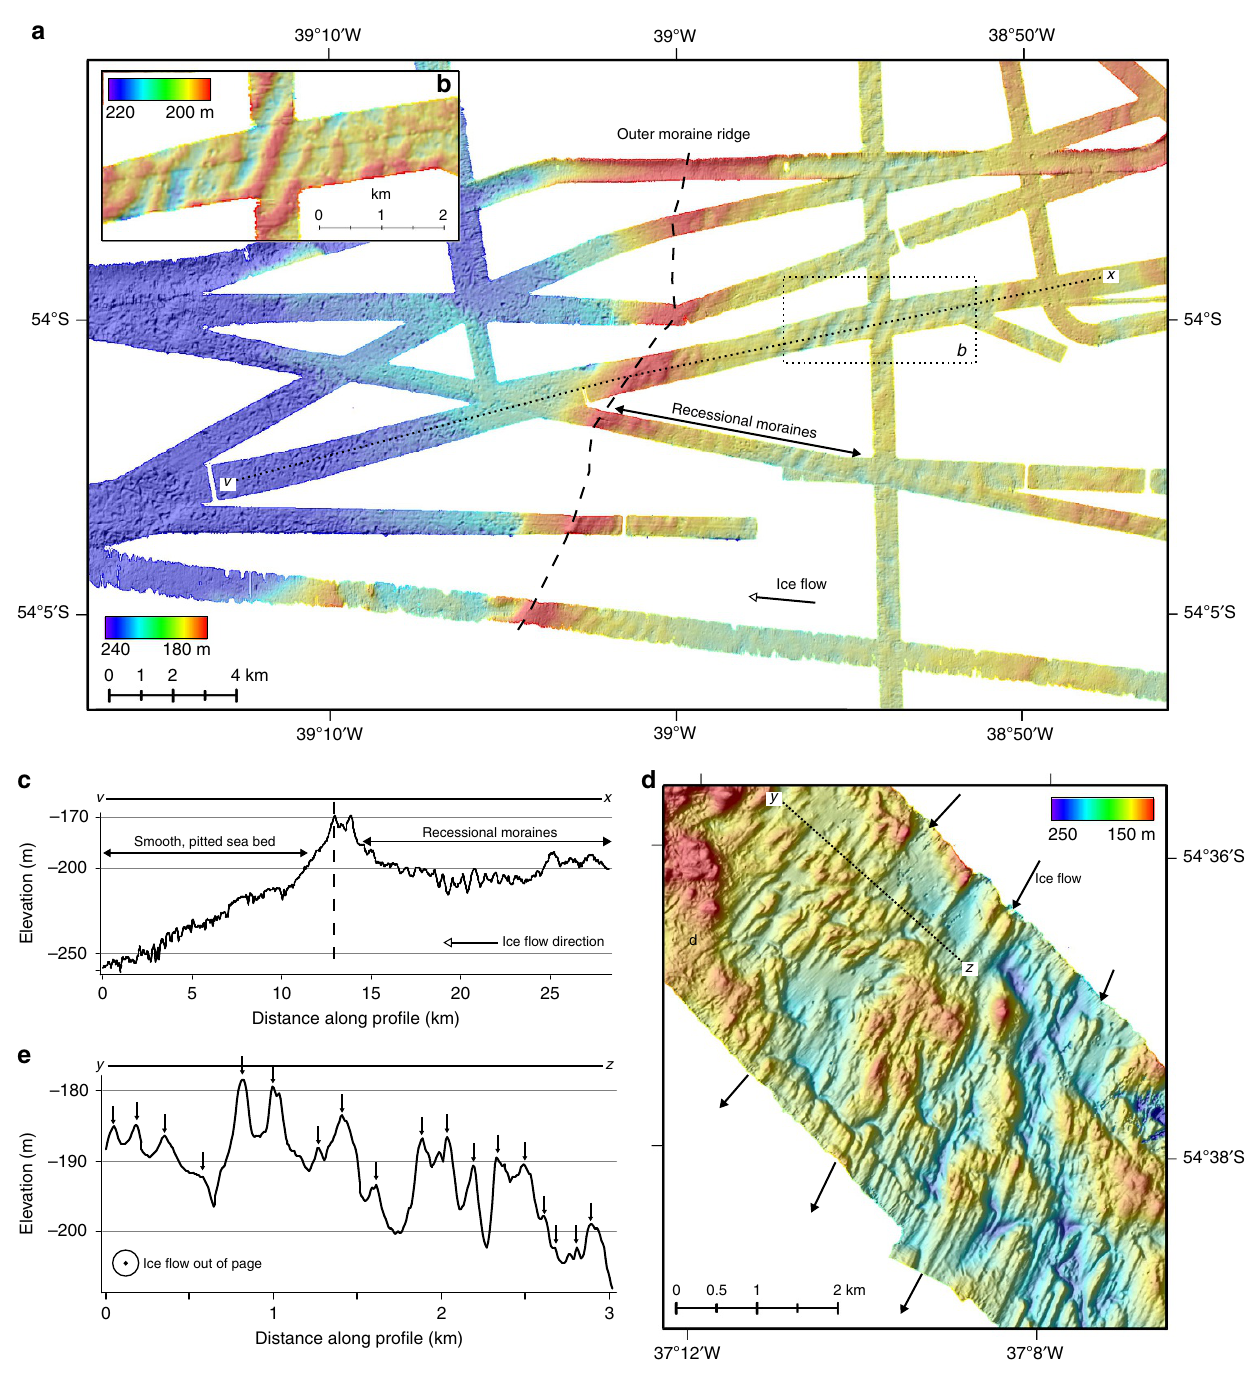
Figure 3 | Detailed multibeam swath bathymetry maps showing glacially-formed landforms. ( a ) Compiled swath bathymetry tracks west of the island illustrating a large outer ridge and back-stepping recessional moraines; profile v – x through the ridge shown in ‘ c ’; ( b ) a sub-set of the recessional moraines in detail. ( c ) profile v – x through the outer ridge showing the separation of deeper, pitted sea-floor and moraine-mantled topography inshore. ( d ) streamlined subglacial bedforms south of the island, resembling drumlins formed by warm-based, fast glacial flow. ( e ) topographic profile y – z across the bedforms illustrating their range of amplitudes and typical wavelengths. Profile located in ‘ d ’. Data in ‘ a ’ gridded at 5m grid cell size, and at 8m grid-cell size in ‘ d